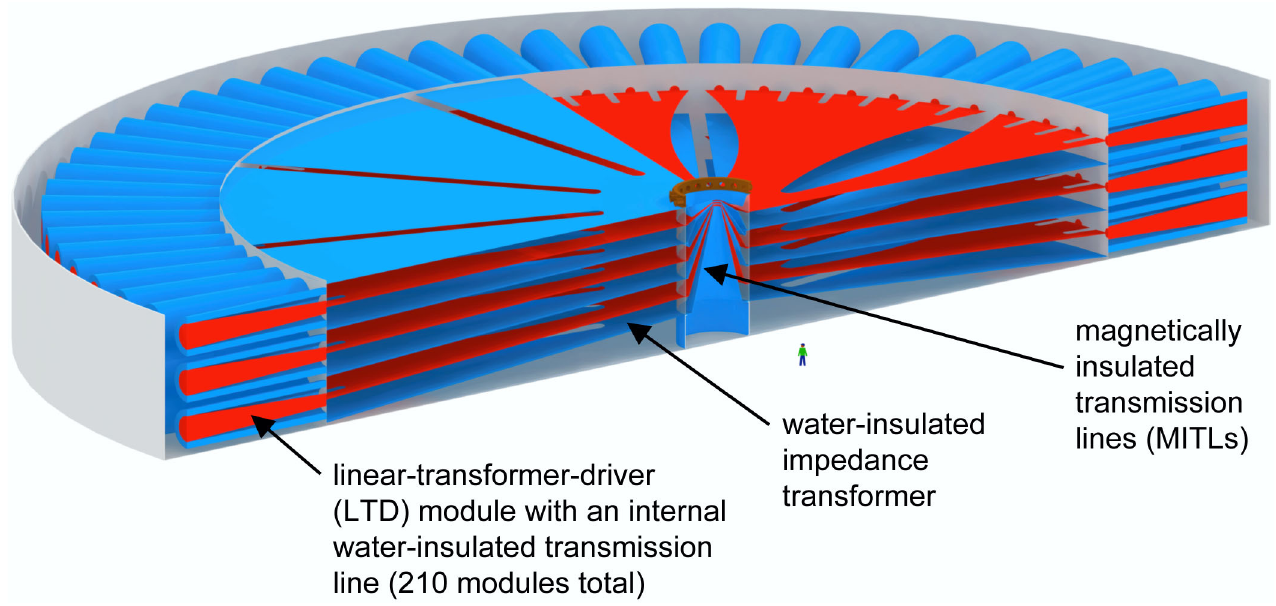
FIG. 1. (Color) Conceptual design of a 1000-TW LTD-driven pulsed-power accelerator [37]. The illustration is approximately to scale. The diameter of the outer-tank wall is 104 m. The illustration includes a person standing near the central MITL